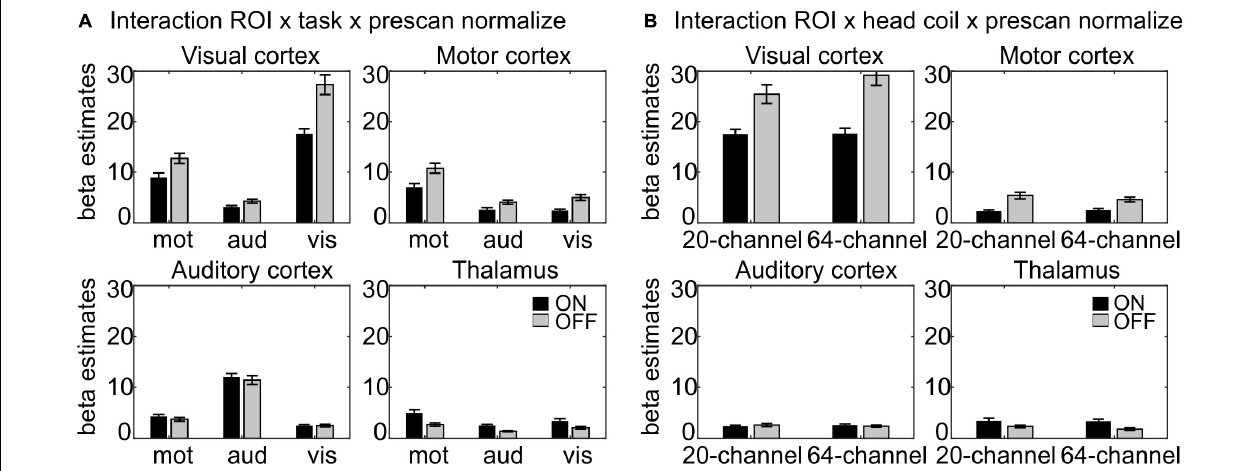
FIGURE 3 | Results of the interactions (A) ROI × task × prescan normalize and (B) ROI × head coil × prescan normalize, separated for each ROI. (A) Largest β estimates in each ROI correspond to the respective task. Note that participants saw numbers on the screen in the motor task, thus resulting in enhanced β estimates in the visual cortex also for the motor task. There were differences regarding the prescan normalize filter with larger β estimates for prescan normalize OFF (gray) in the visual and motor cortices, whereas there was no difference between prescan normalize ON (black) and OFF in the auditory cortex and even the contrary pattern with larger values for prescan normalize ON in the thalamus. (B) Regarding the differences in the head coils, there were larger β estimates for the prescan normalize OFF in the visual and motor cortices, whereas again, there was no difference in the auditory cortex, but larger values for prescan normalize ON in the thalamus. ROI, region of interest.